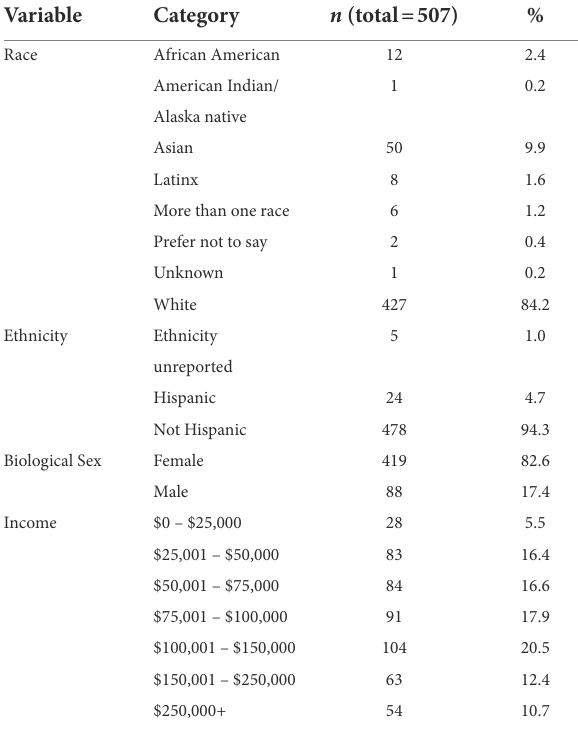
TABLE 1 Demographics (full sample).